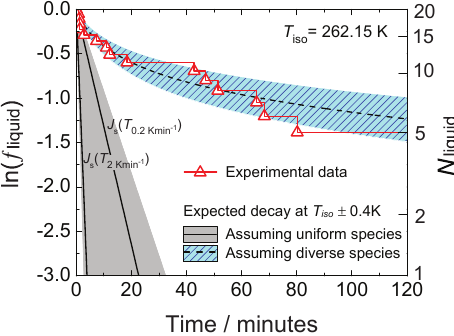
Figure 7. Decay of liquid droplets containing K-feldspar in an isothermal experiment at T iso = 262.15K, and simulated experi- ments assuming a uniform and diverse distribution. For the uniform distribution J s (T iso ) values were taken from Fig. 6a (thus assuming a single-component system where J s = R/A ) and used with Eq. (1), resulting in a decay bounded by the range of R/A between the two cooling rates of 0.2 and 2.0Kmin − 1 . For the diverse simulation the MCSM was used with parameters determined through fitting to the normalised K-feldspar data set in Fig. 6: µ = 890.5, σ = 3.8 (see Fig. 1), and λ = 3.4K − 1 (determined in Fig. 6). The shaded regions follow the instrument-based error of ± 0.4K around T iso . The trian- gular symbols indicate when freezing events occurred throughout the 120min duration of the